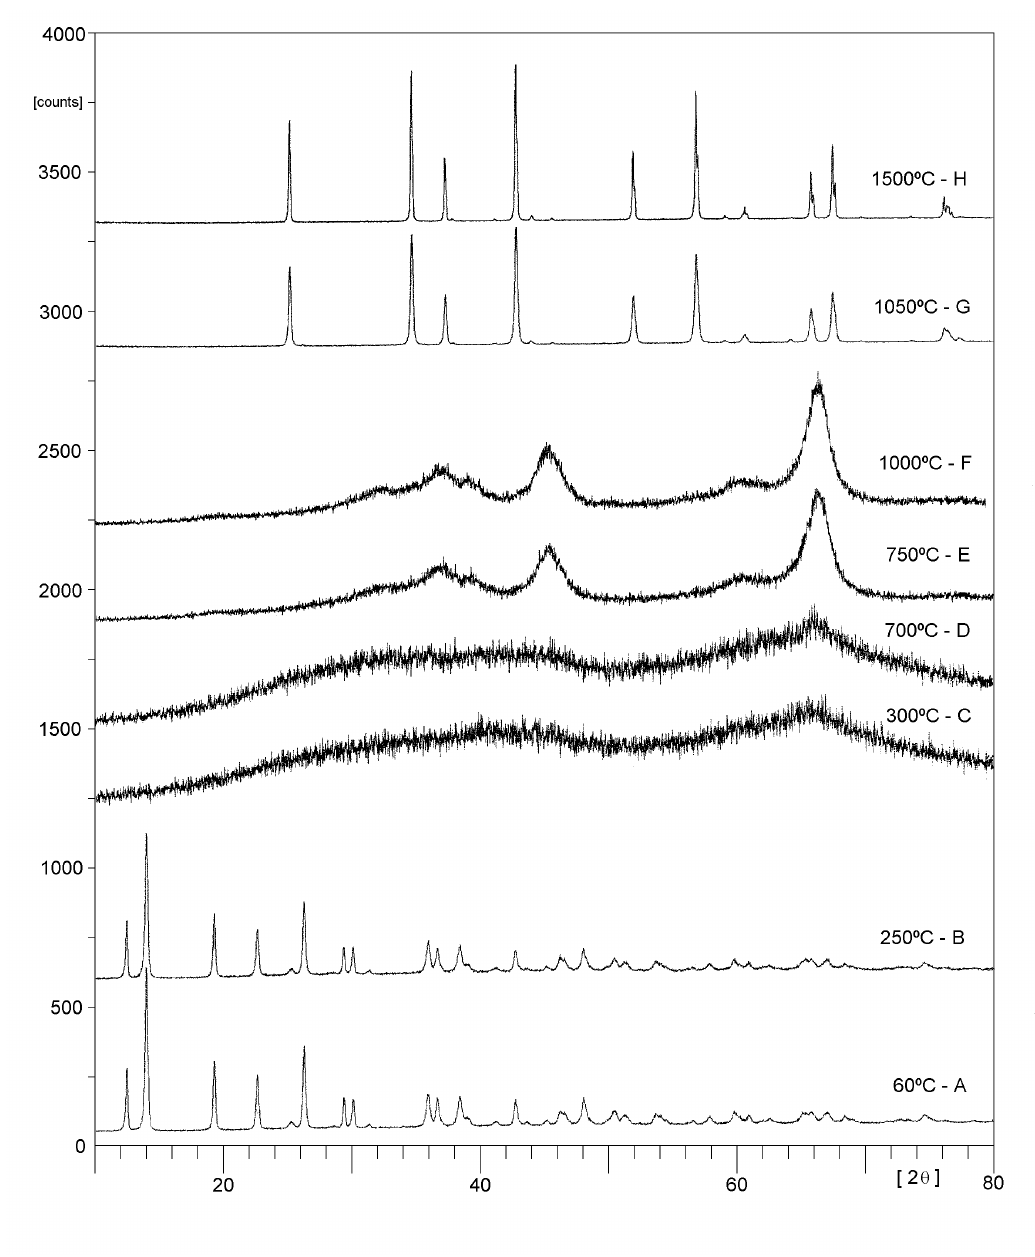
Fig. 2 – X-ray diffraction curves of crystals of Al(OH)Ac 2 at the temperatures of formation of the transition